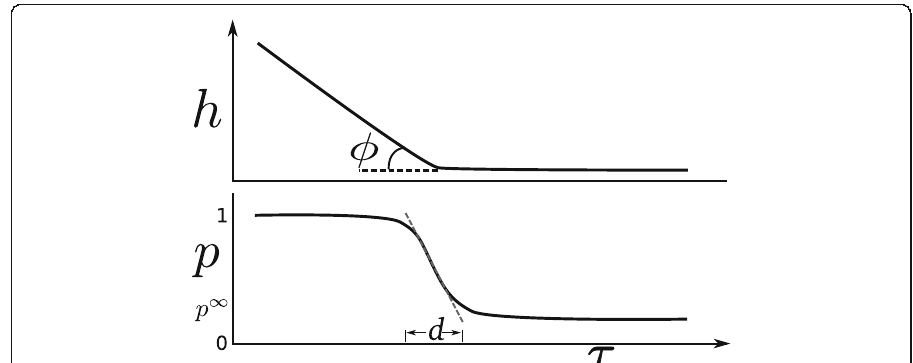
Fig. 5 Expected solution of the system in the neighbourhood of the interface showing ( top ) the expected profile of h with the simulated contact angle ϕ and (bottom) the expected profile of p varying between p ∞ and 1 over an interface width,